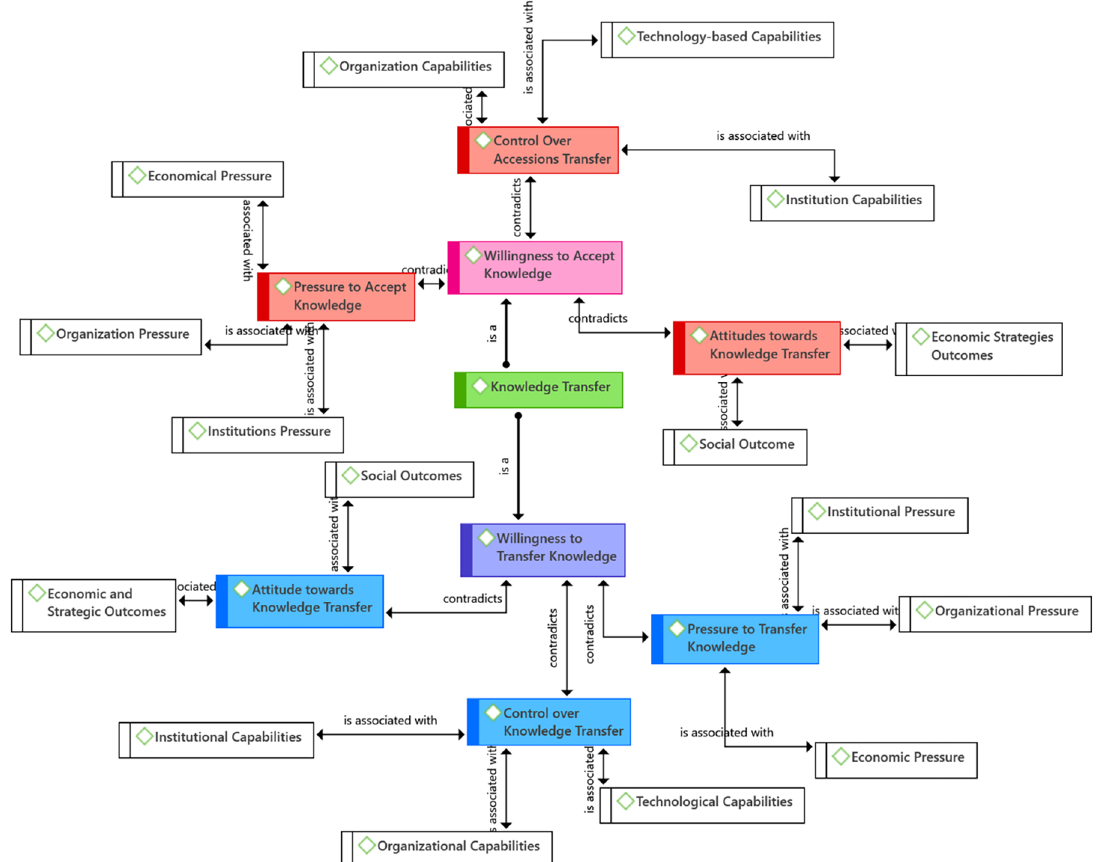
A model of applied knowledge